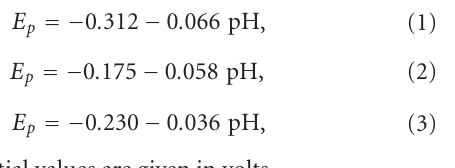
a = 50 mV and Δ E = 2 mV. Figure 2 shows the responses s obtained for 4-NP on the AgSAE at di ff erent pH values, where the insert indicates the responses for I p and E p as a function of the pH values